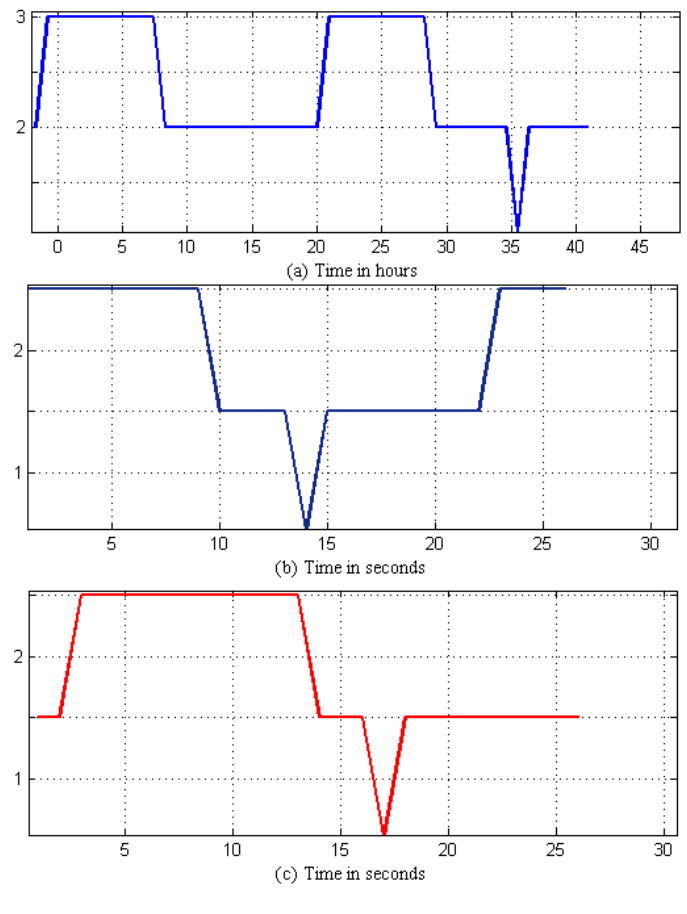
Figure 8. ( a ) Consumption patterns (CPs) (per hour on the x-axis); ( b ) tap event (TE) (per second on the x-axis); and ( c ) seepage event (SE) (per second on the x-axis); quantized state sequences are on the